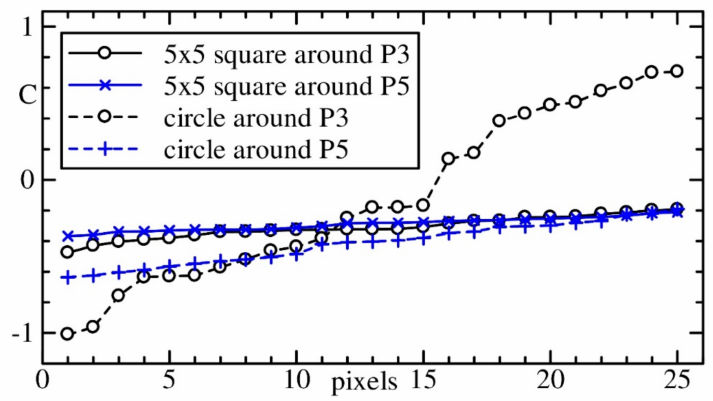
Figure 6. Distributions of C values of 25 pixels in a 5 × 5 square and a circle around the target pixels, P3 and